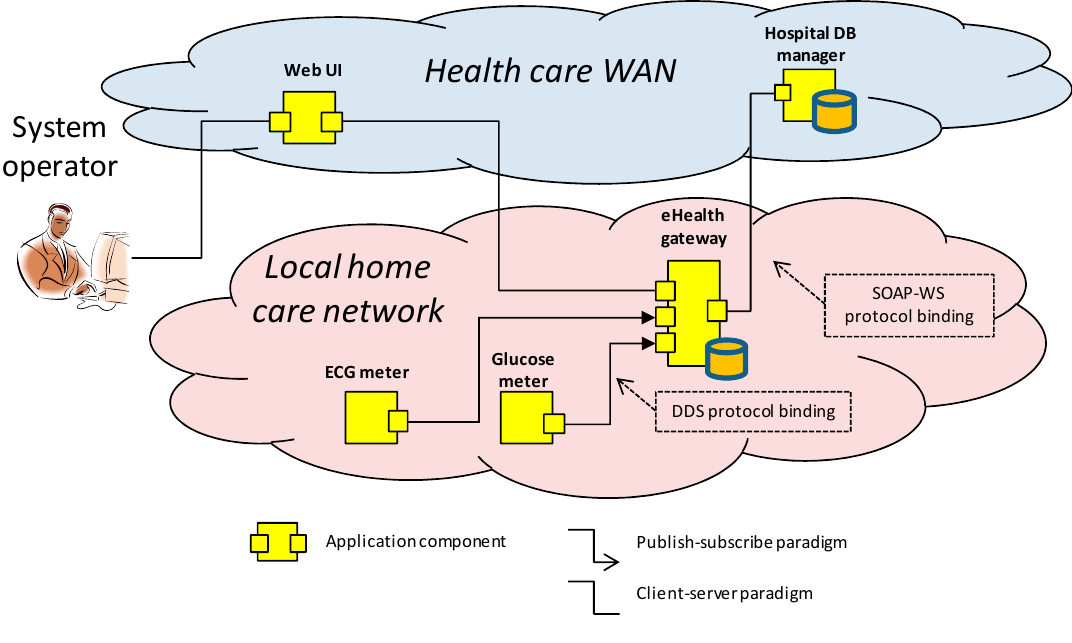
Figure 1. Health monitoring application.